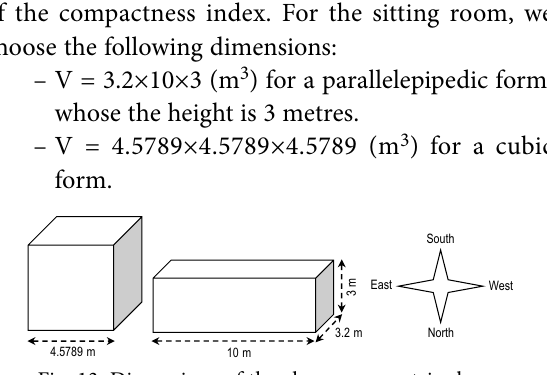
Fig. 13. Dimensions of the chosen geometric